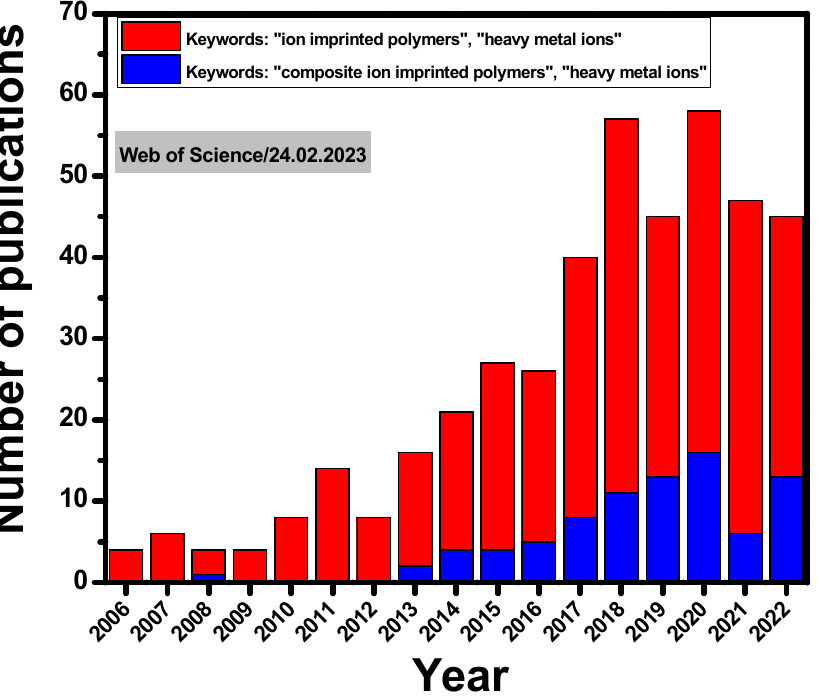
Figure 1. A timeline showing the number of publications on IIPs and composite IIPs in the last 16 years indexed by the Web of Science™ database. years indexed by the Web of Science™